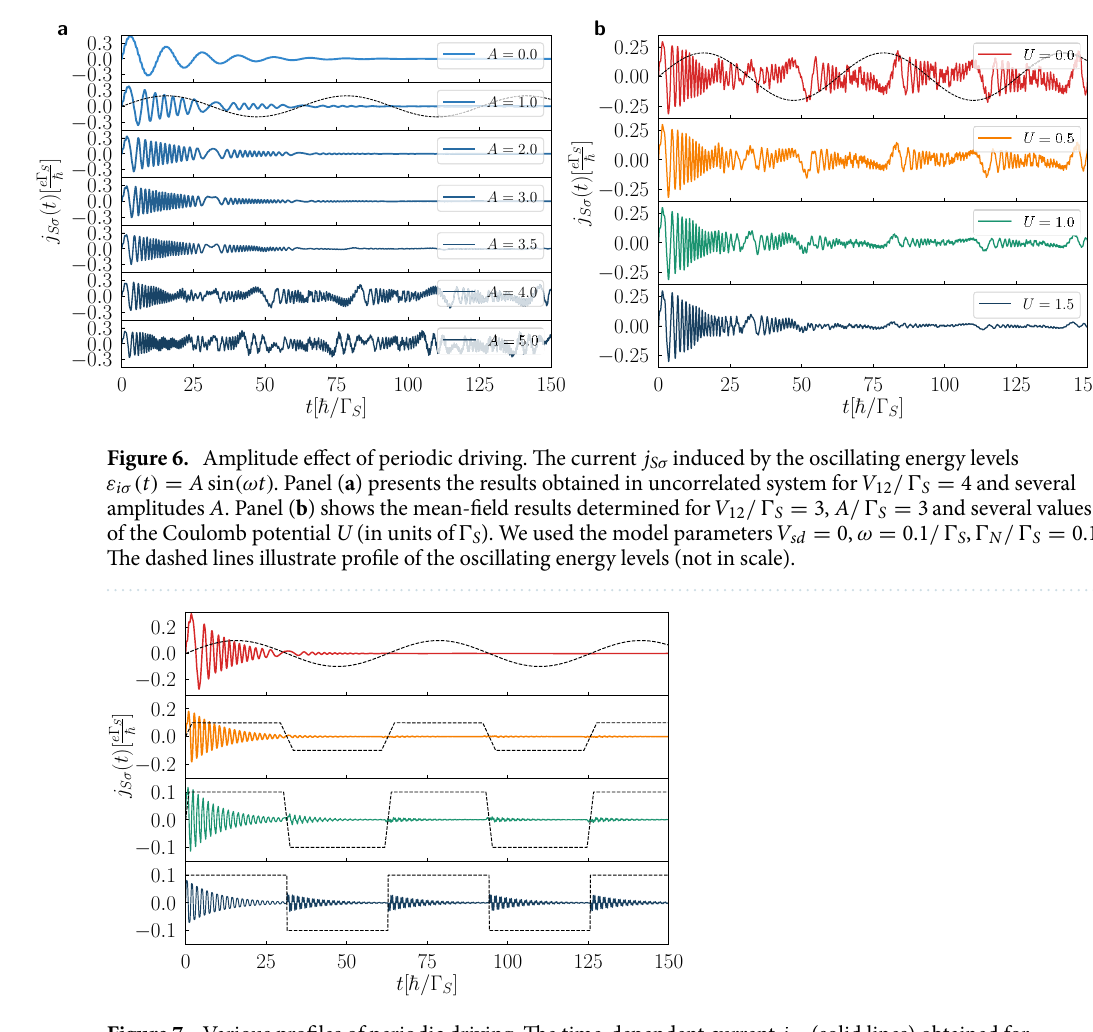
0 , Ŵ 0.2 , V 0 N /Ŵ S = sd = =